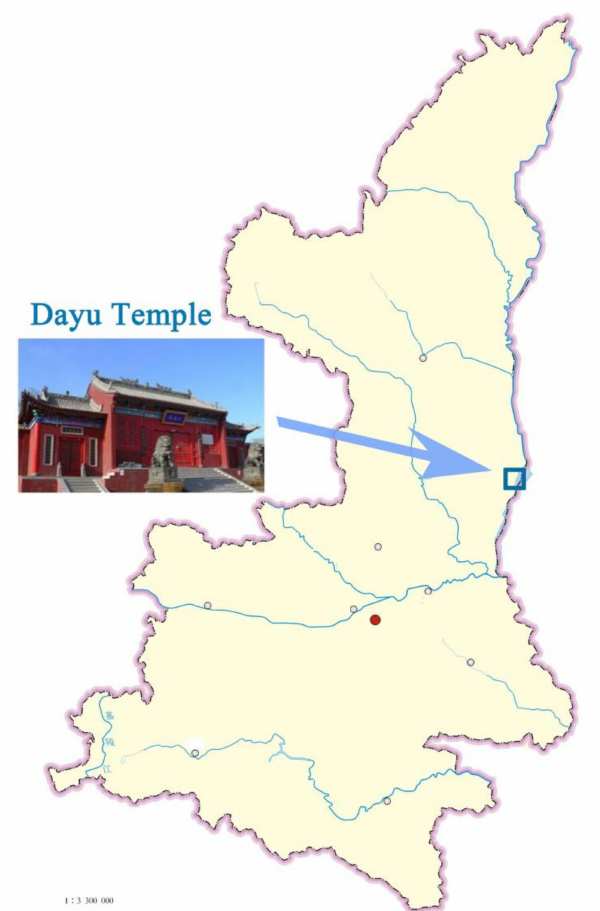
Figure 1. The location of Dayu Temple in Hancheng, Shaanxi Province, China.